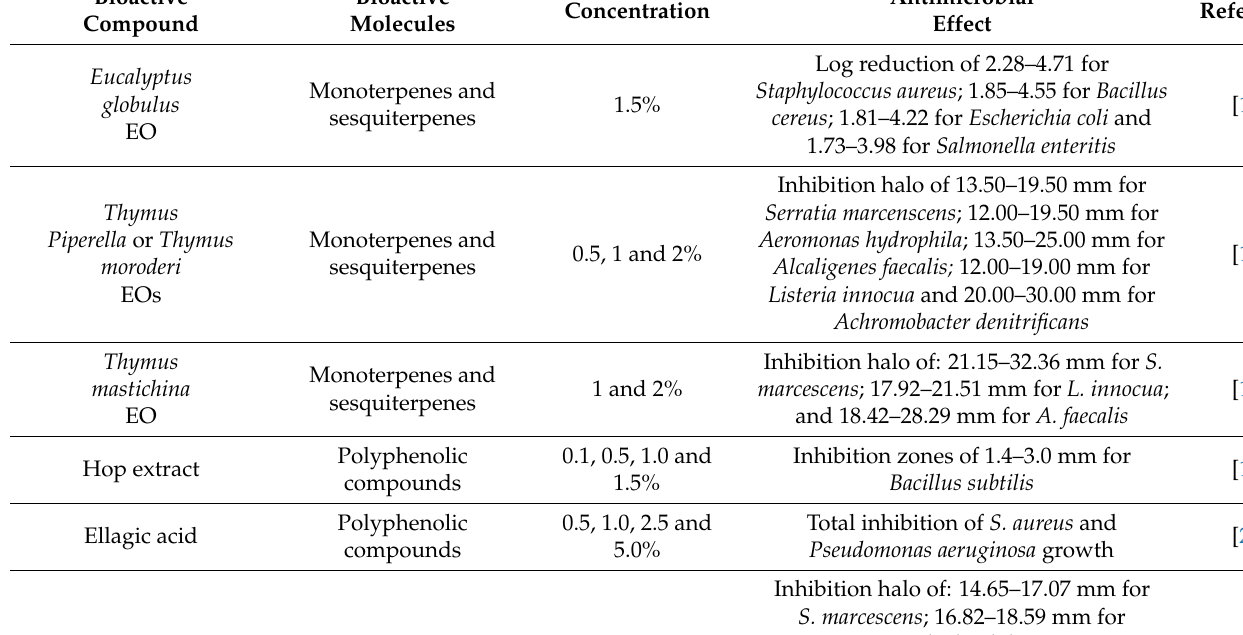
Table 1. Antimicrobial compounds added to chitosan-based composites for the development of bioactive chitosan edible films and